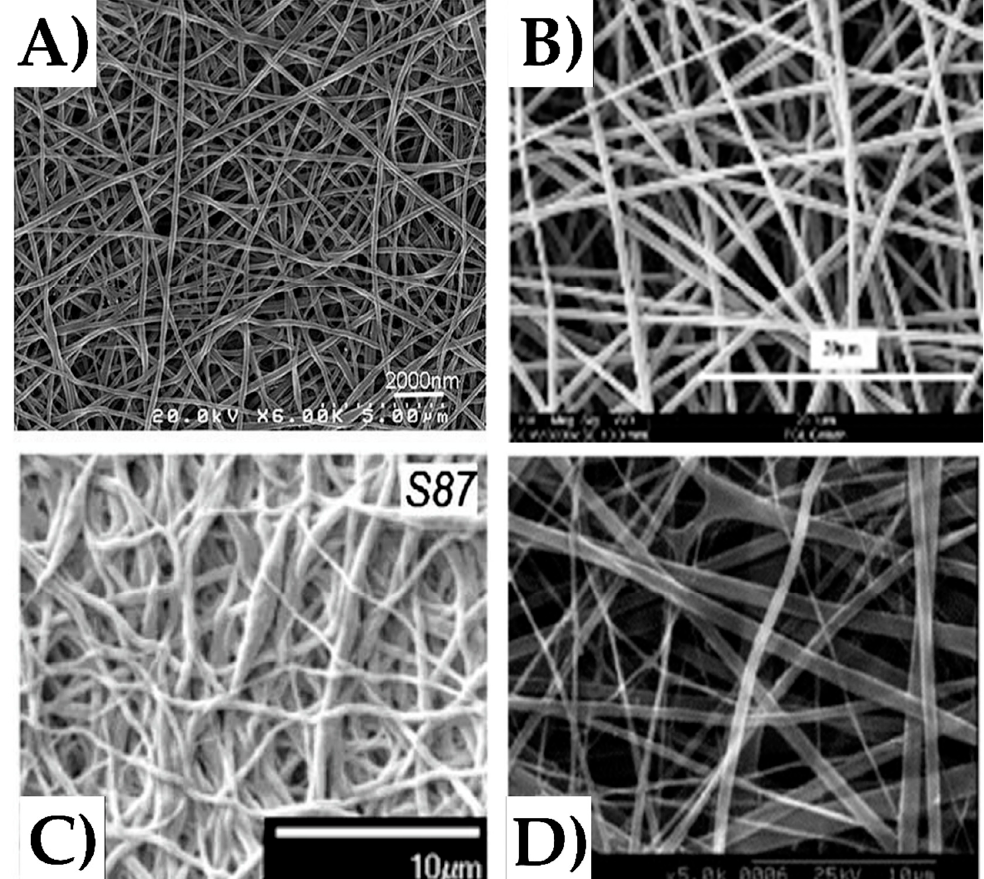
Figure 3. Scanning electron microscope images of ( A ) pure silk nanofibers, ( B ) PCL-gelatin nanofibers,